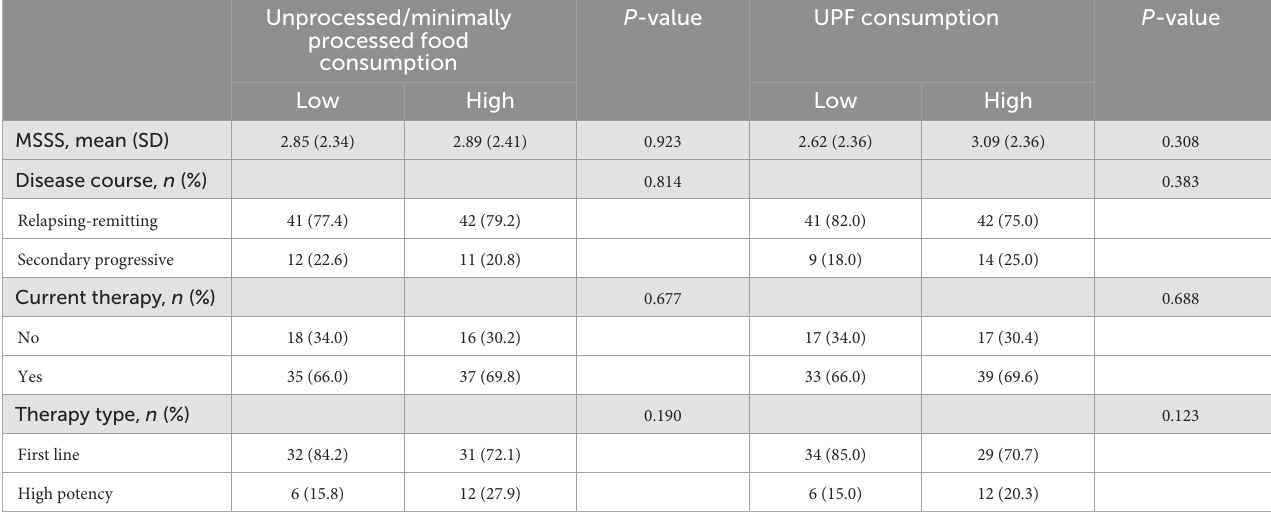
TABLE 2 Clinical characteristics of the study sample according to consumption of foods by level of processing according to NOVA classification in the study sample ( n = 106). Unprocessed/minimally processed